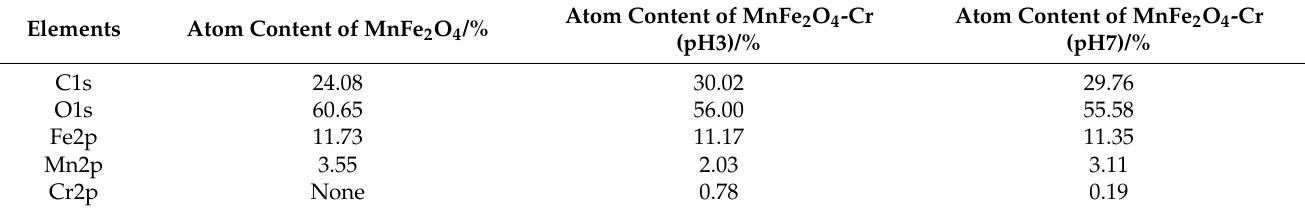
Table 5. Atom contents of the surfaces of the three samples.